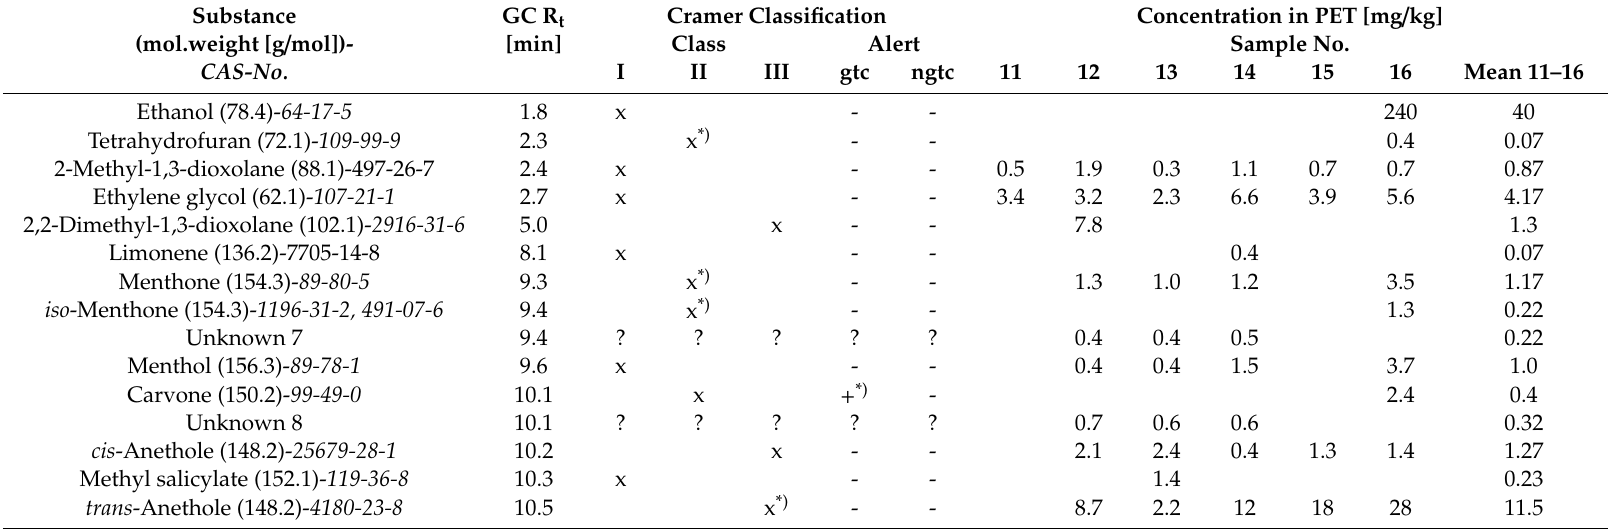
Table 3. Substances found in PET bottles originally used for mouthwash